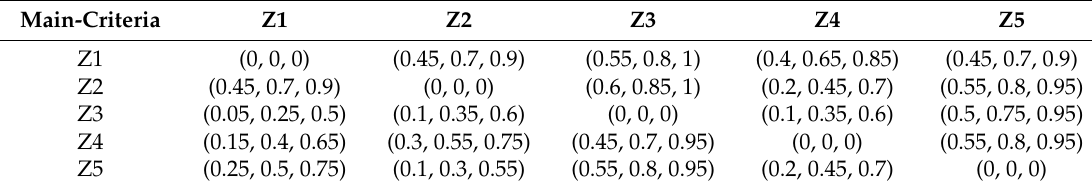
Table 8. The initial direct relation matrix of the main criteria.